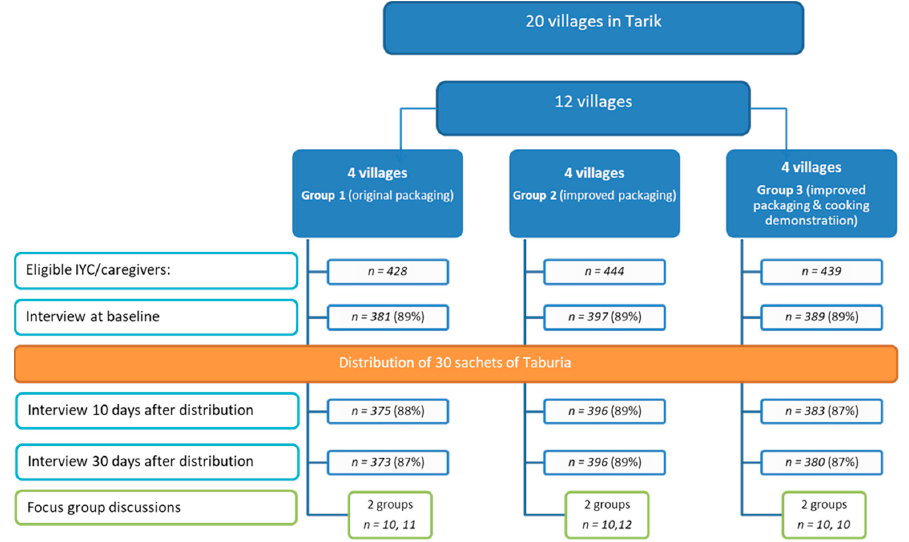
Figure 2. Study design and number of infants and young child/caregiver dyads participating in each study phase.